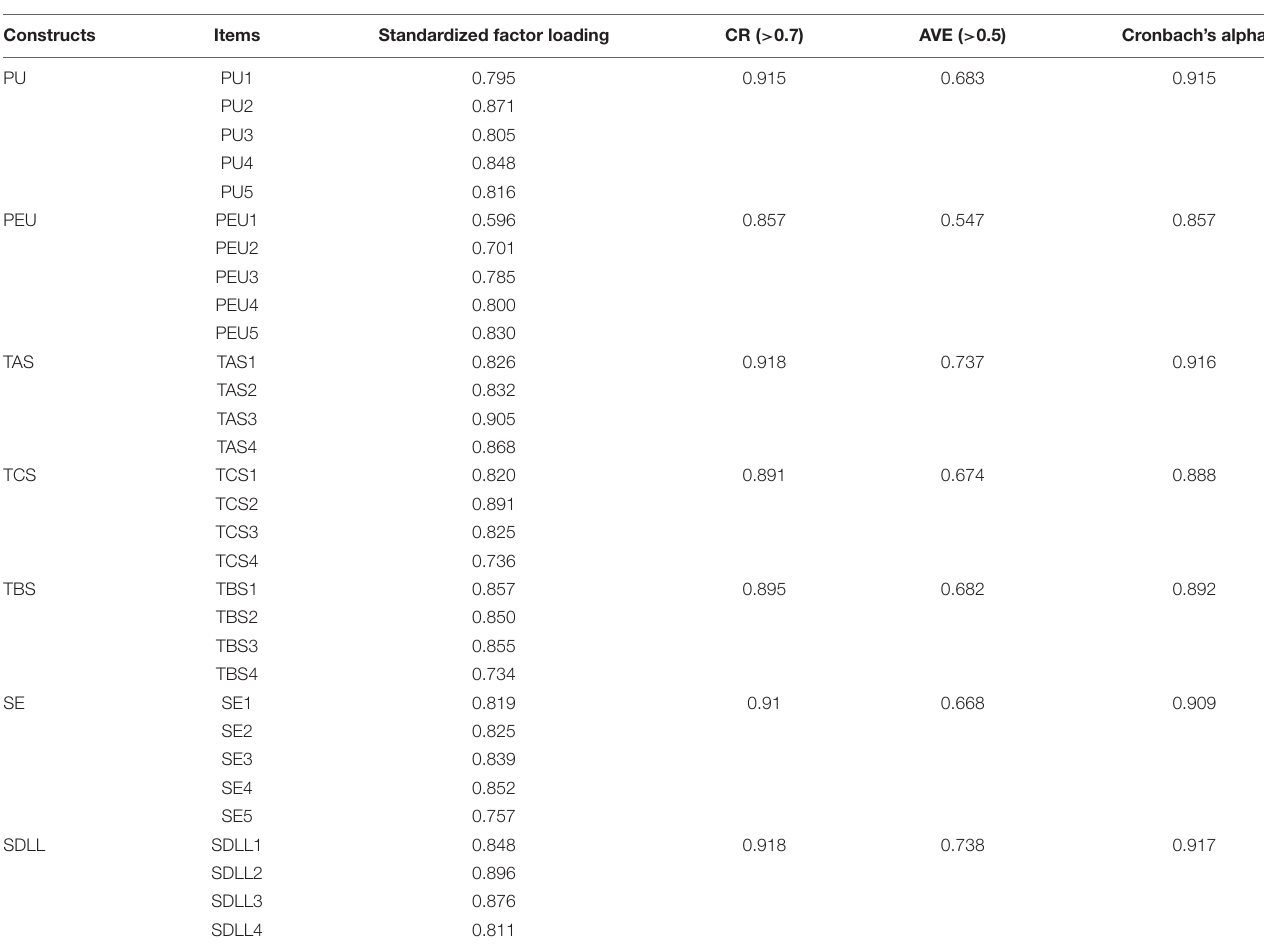
TABLE 3 | The convergent and discriminant validity of the measurement model. Constructs